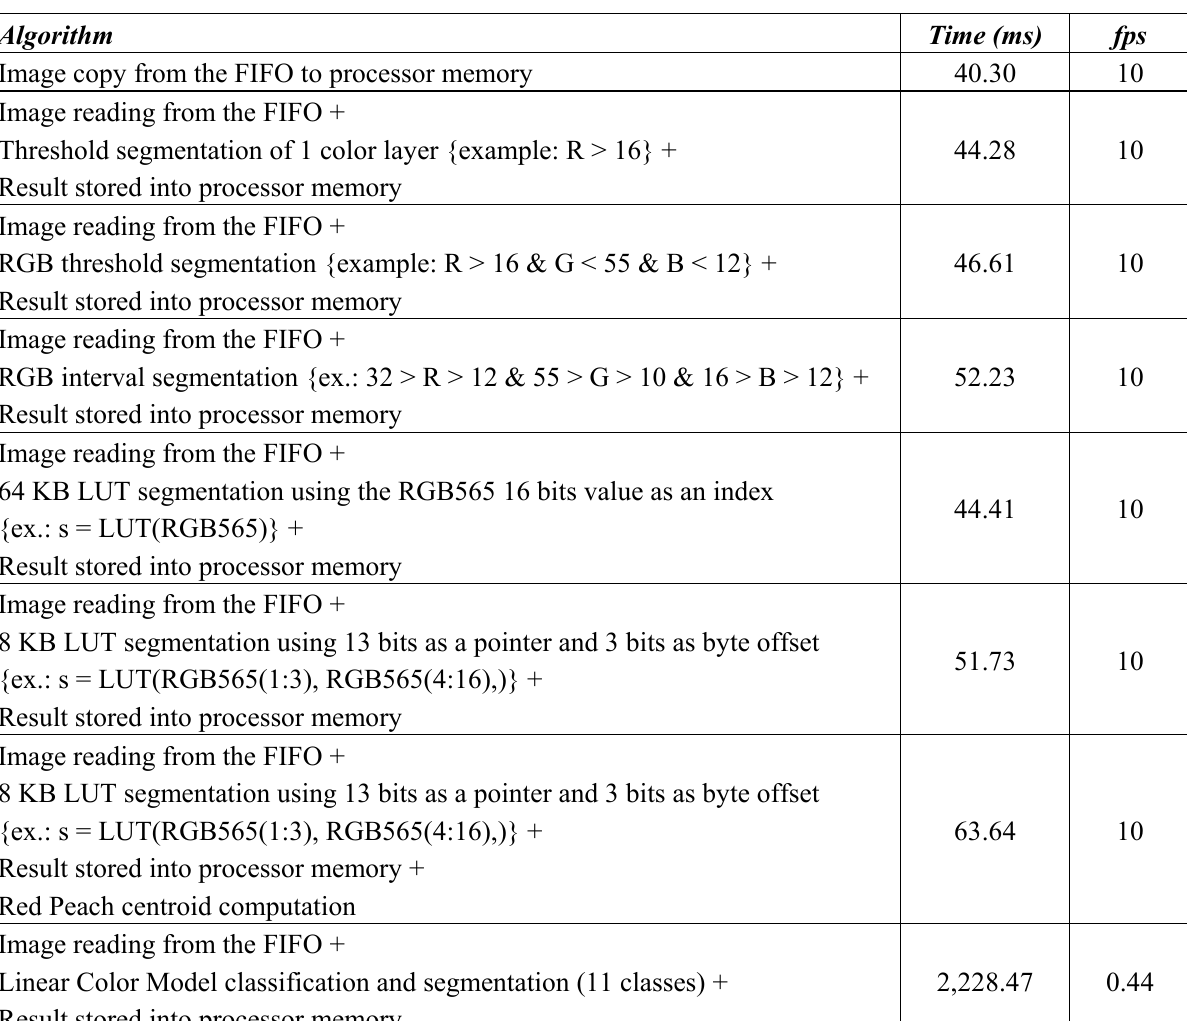
Table 1. Segmentation algorithm, time required to perform the operations and the real frame rate